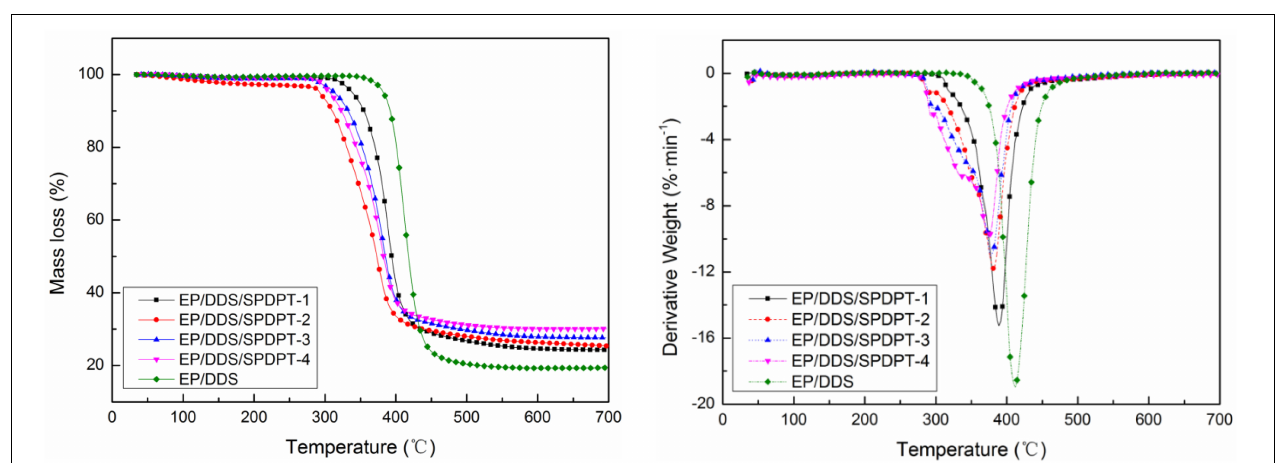
FIGURE 6 | TG and DTG curves of SPDPT.